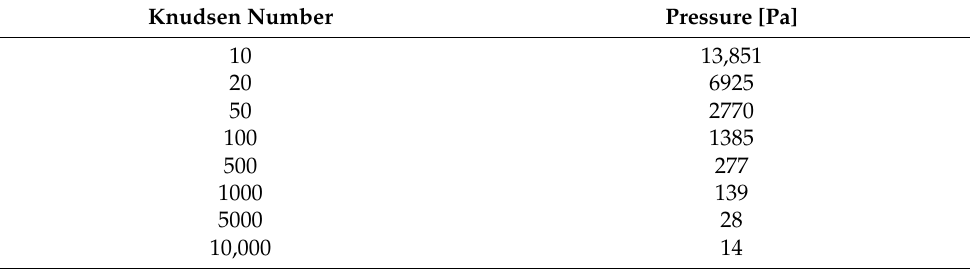
Table 2. Pressure for Knudsen number [ d p = 100 nm, T = 300 K ] .